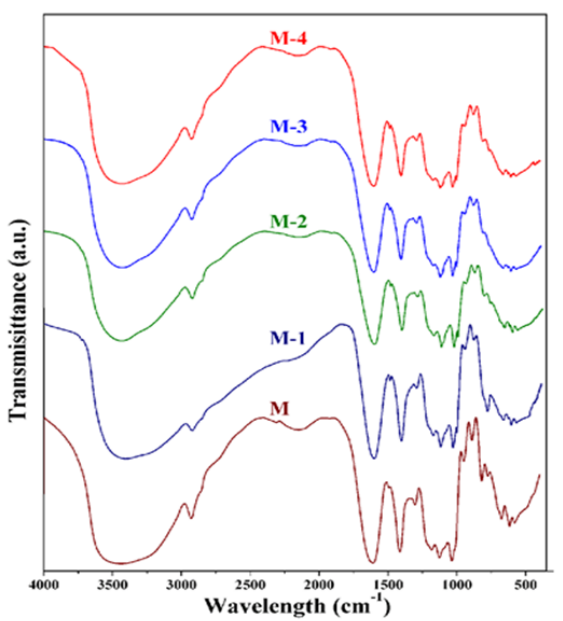
Figure 1. FTIR spectra of crosslinked sodium alginate and related nanocomposite membranes. M: 0%, M-1: 10%, M-2: 20%, M-3: 30%, and M-4: 40% TiO 2 (all % w / w ).